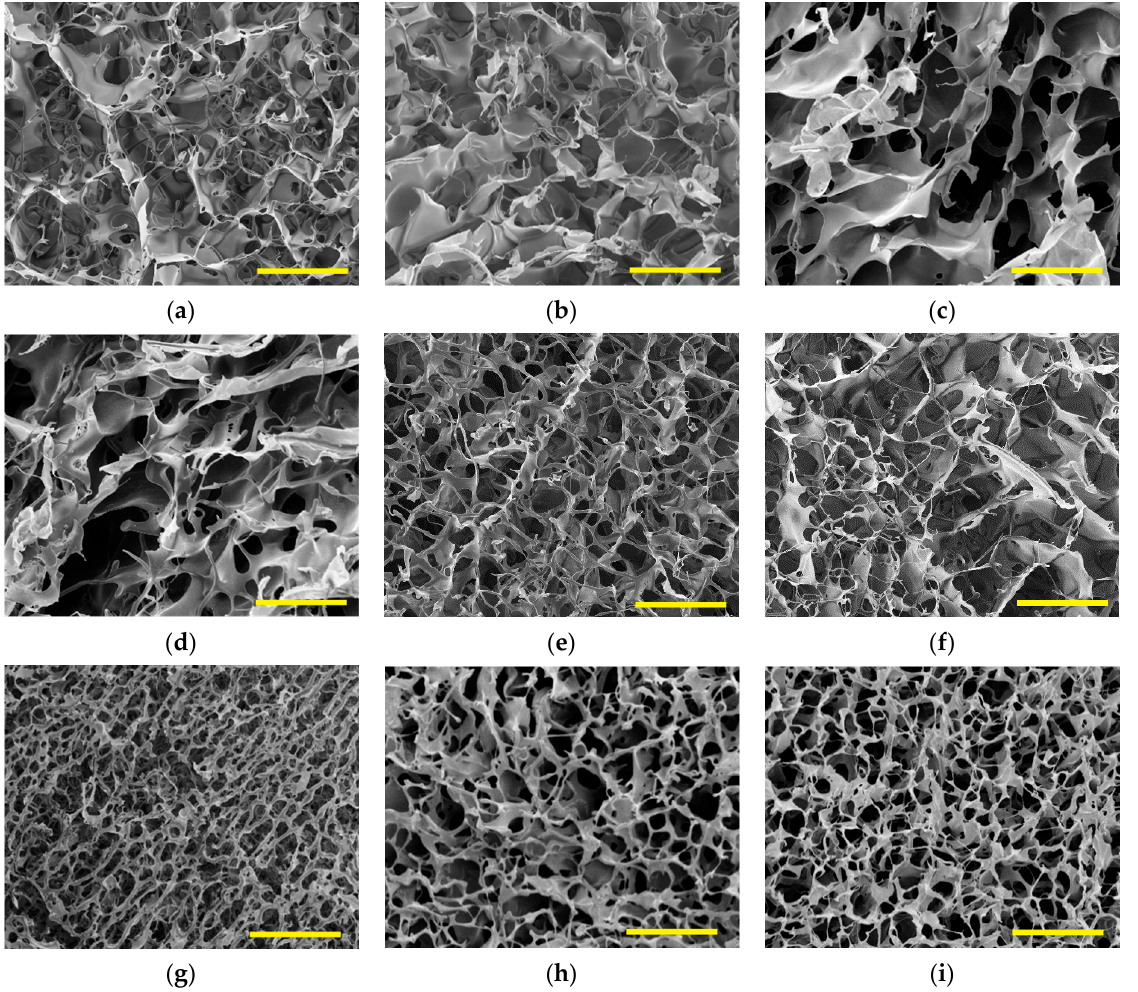
Figure 3. SEM images of ( a ) HPMC, ( b ) K0.5, ( c ) K2.75, ( d ) K5, ( e ) K7.25, ( f ) AOT0.5, ( g ) AOT2.75, ( h ) AOT5, and ( i ) AOT7.25. The scale bars correspond to 200 µm.